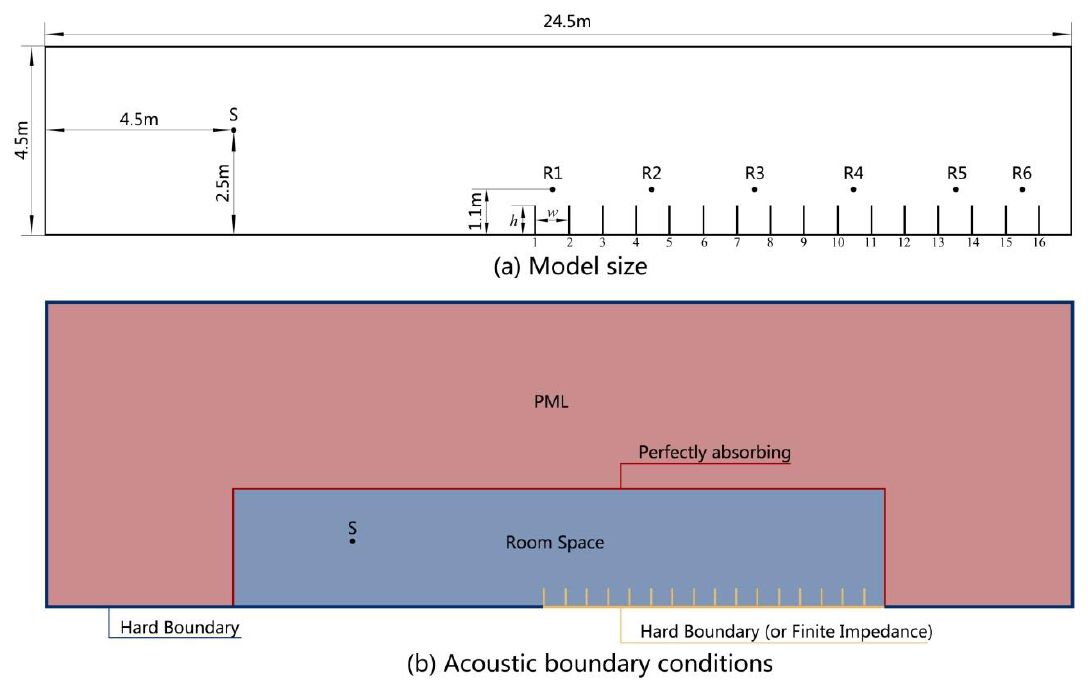
Figure 1. Setup of the simulation model: ( a ) geometry and ( b ) acoustic boundary conditions.